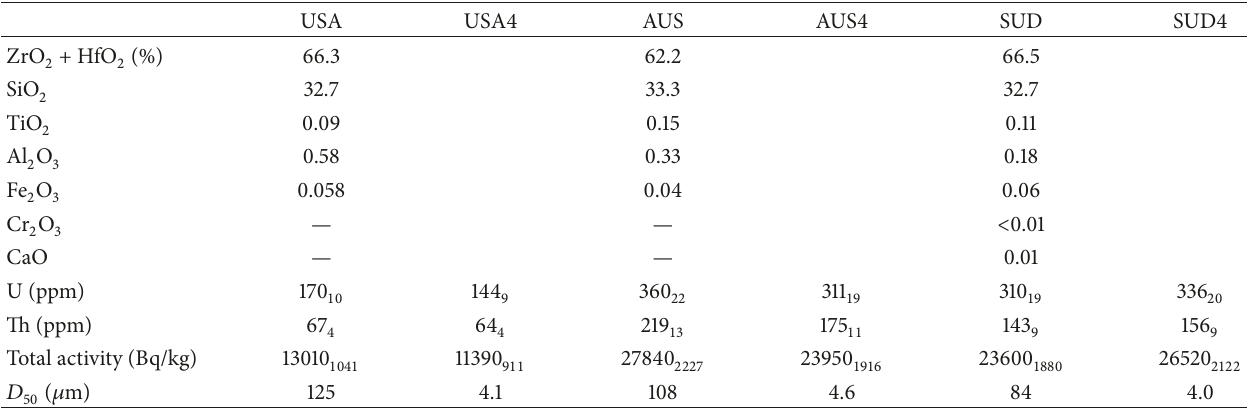
Table 1: Chemical composition (provided by Endeka Ceramics) for natural zircon sands. U and Th content and granulometry determined in natural and micronized zircon sands. USA USA4 AUS AUS4 SUD SUD4 66.3